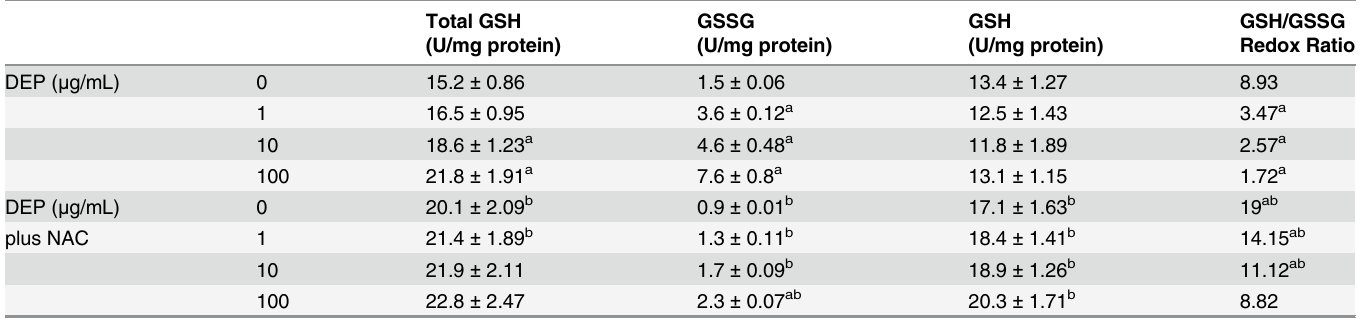
Table 1. Cytoplasmic Total, Oxidized and Reduced Glutathione Levels and GSH/GSSG Redox Ratio in the tube cells treated with DEP ± NAC. Total GSH, total glutathione; GSSG, oxidized glutathione; GSH, reduced glutathione. Values are given as mean ± SD of n = 3 experiments and duplicate measure- ments. The concentrations of DEP used are 1, 10, and 100 μ g/mL, NAC is 10 mM. DEP (0 μ g/mL) presents as the negative